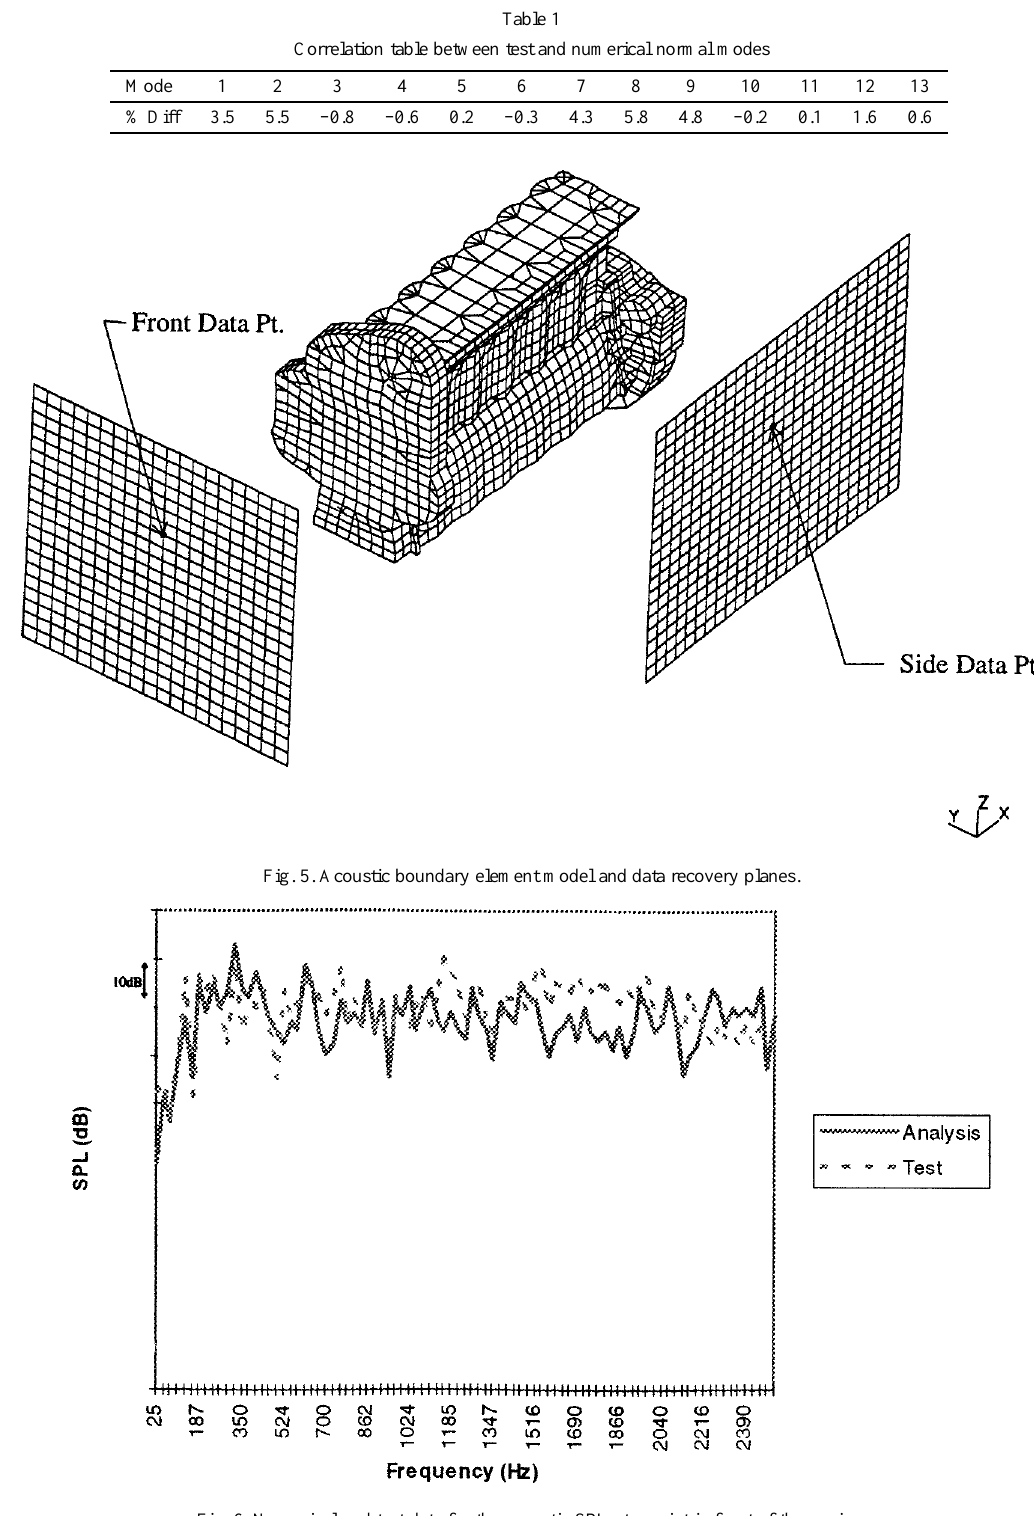
Fig. 6. Numerical and test data for the acoustic SPL at a point in front of the